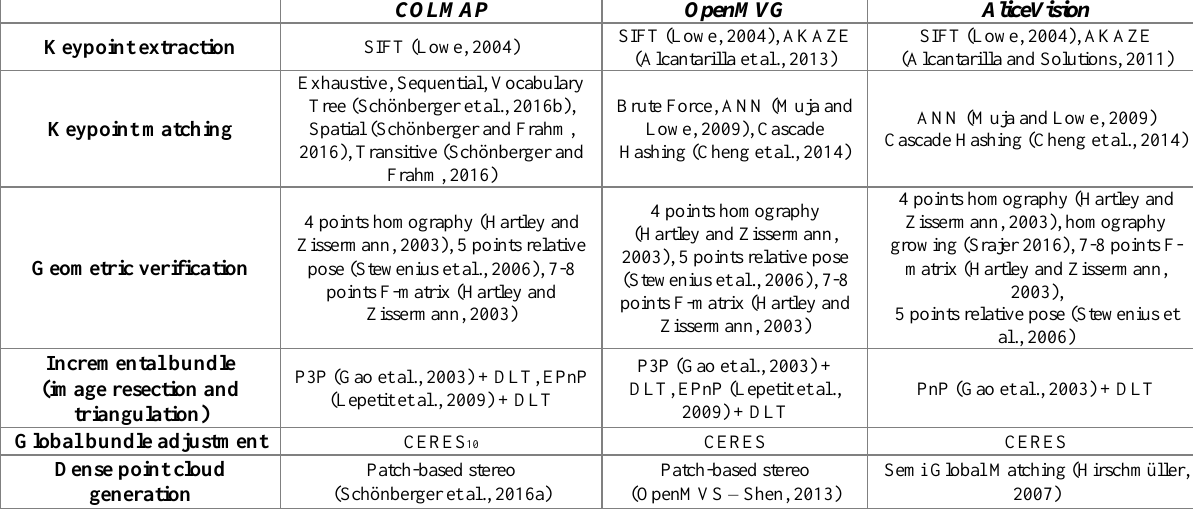
Table 2: Open-source image-based 3D reconstruction pipelines analysed in this